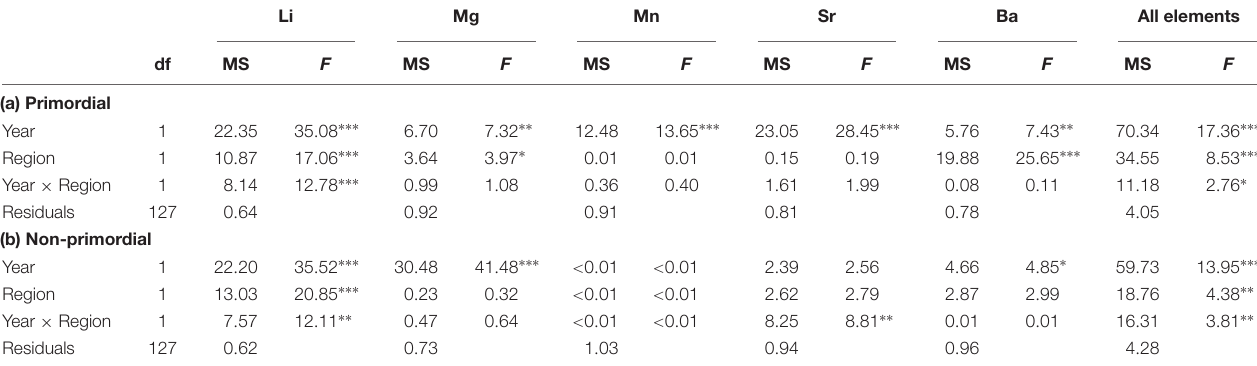
TABLE 2 | Summary of two-factor PERMANOVAs for the effect of year and region on individual and combined element: Ca ratios for the (a) primordial area and (b) non-primordial area of larval King George whiting otoliths. Li Mg Mn Sr Ba All elements